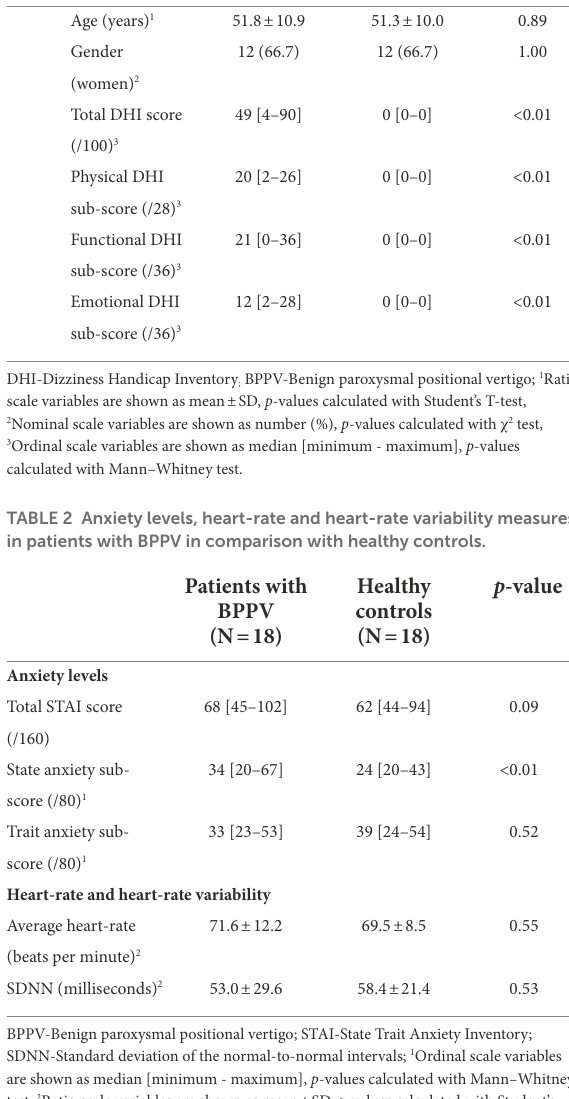
TABLE 1 Demographics and DHI questionnaire scores of patients with BPPV in comparison with healthy controls. Patients with